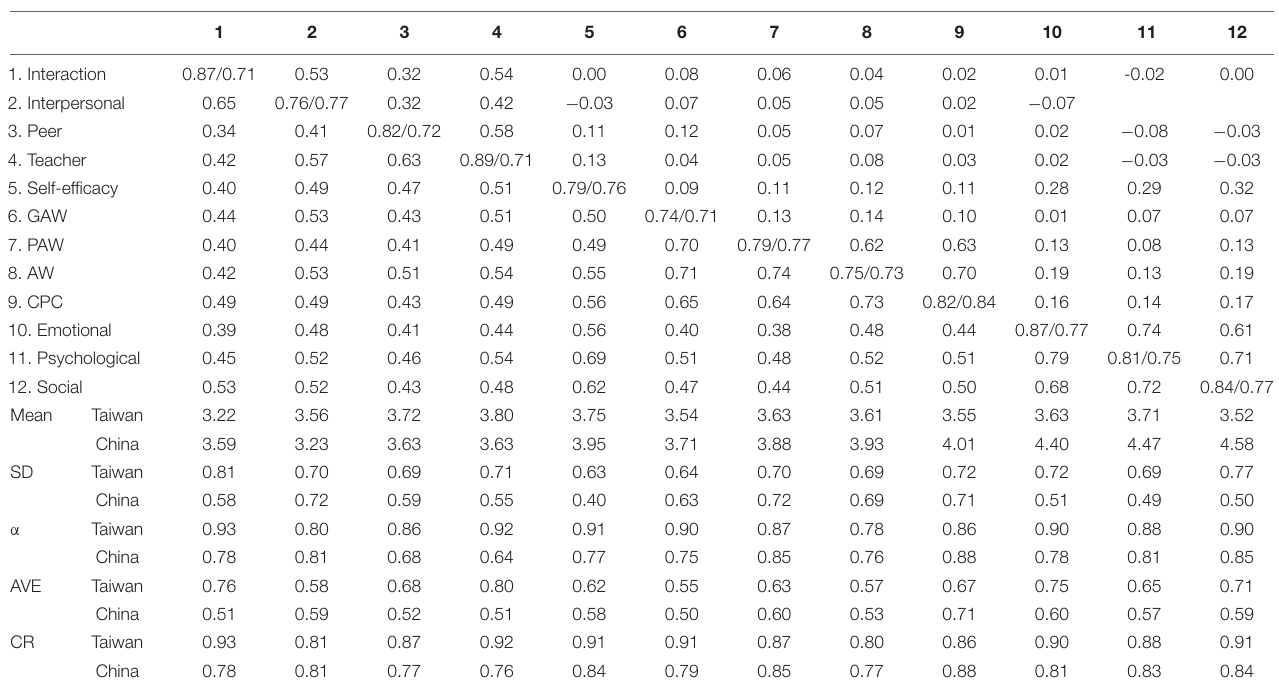
TABLE 2 | Measurement